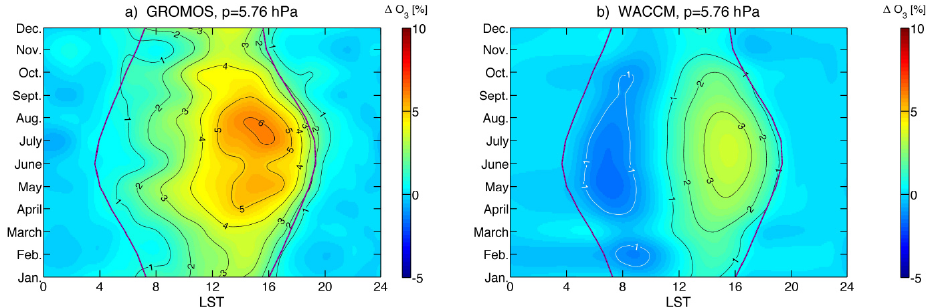
Figure 7. Mean seasonal behaviour of the diurnal ozone variation for the pressure level 5.76hPa in the stratosphere. (a) shows the observa- tional result of the ground-based microwave radiometer GROMOS at Bern. (b) shows the simulation result of the model WACCM at a grid point near Bern.